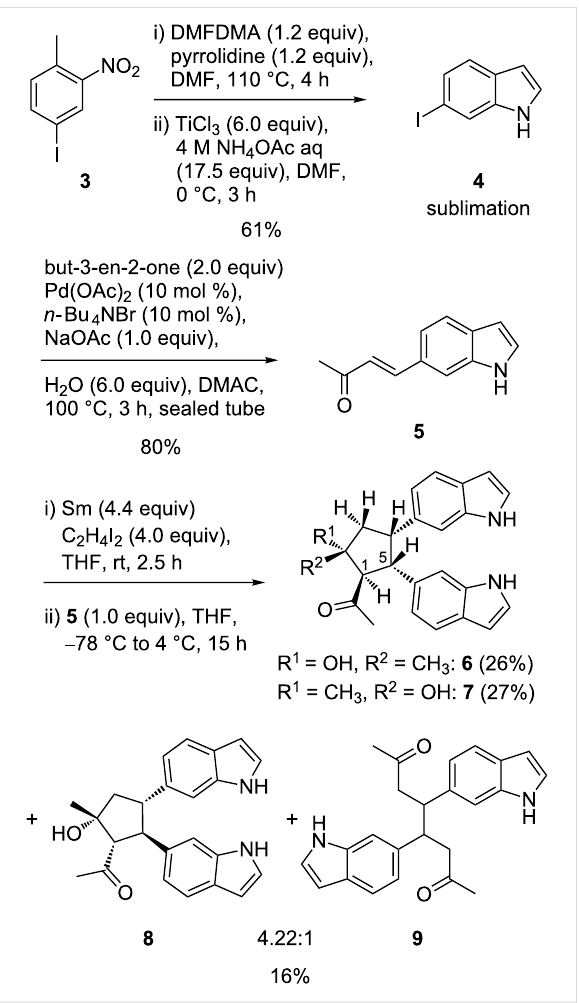
Scheme 1: Synthesis and SmI 2 -mediated reductive dimerization of natural product 5